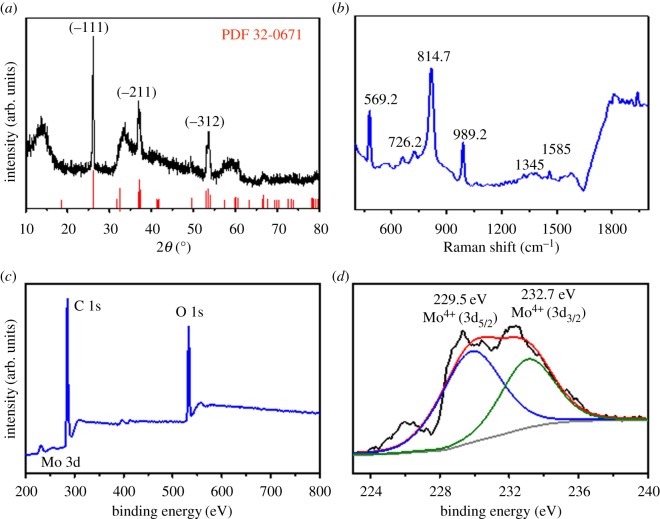
XRD patterns (a), Raman spectrum (b), XPS survey (c), and high-resolution XPS spectra for Mo 3d (d) of the MoO2/C nanosheets.